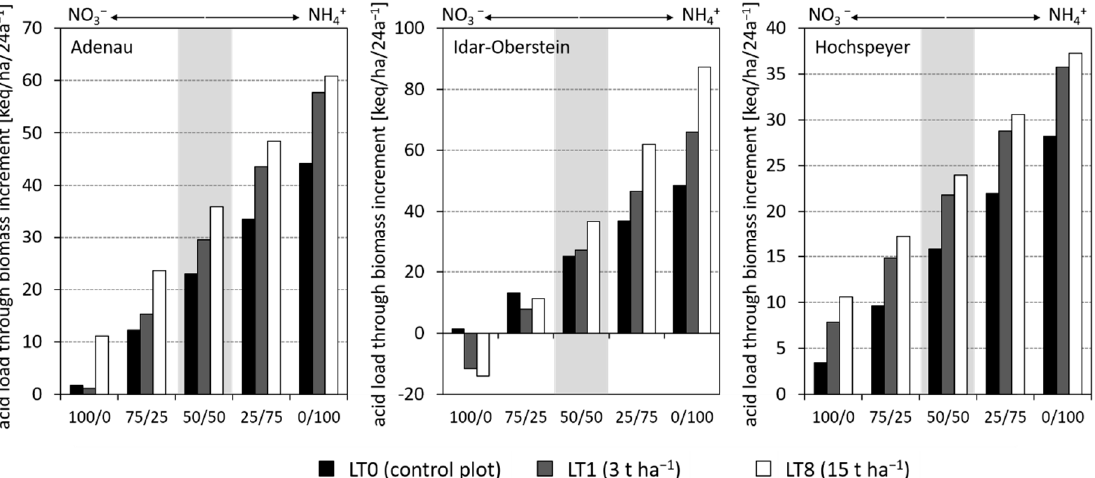
Figure 2. Acid load through biomass increment when NO 3 − and NH 4+ are taken up with different proportions for the control plots and the 3 and 15 t ha − 1 liming treatments of the three study areas. An uptake of N only as NO 3 − (100/0) leads to a lower acid load, an uptake of N only as NH 4+ (0/100) leads to a higher acid load. For the following calculations, it is assumed that NH 4+ and NO 3 − are taken up with the same proportion (50/50, highlighted in the figure by the grey area). Negative values in IO stand for proton consumption by biomass increment.